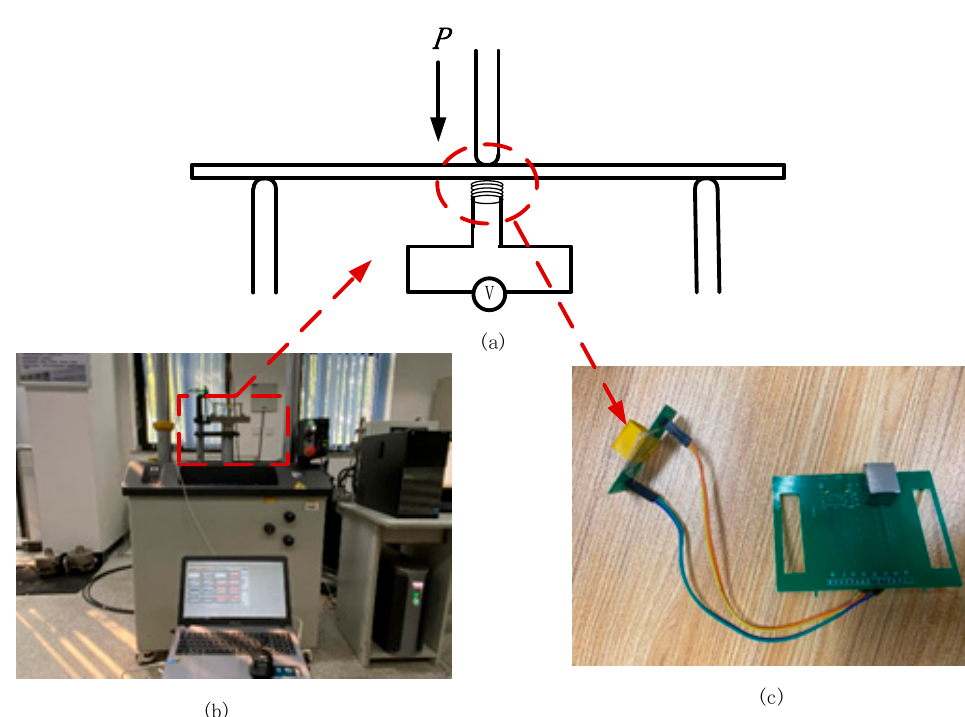
Figure 10. Quasistatic bending test system and sensor probe ( a ) is a simple schematic diagram of the experimental system; ( b ) the actual scene photo; and ( c ) the eddy current coil sensor.